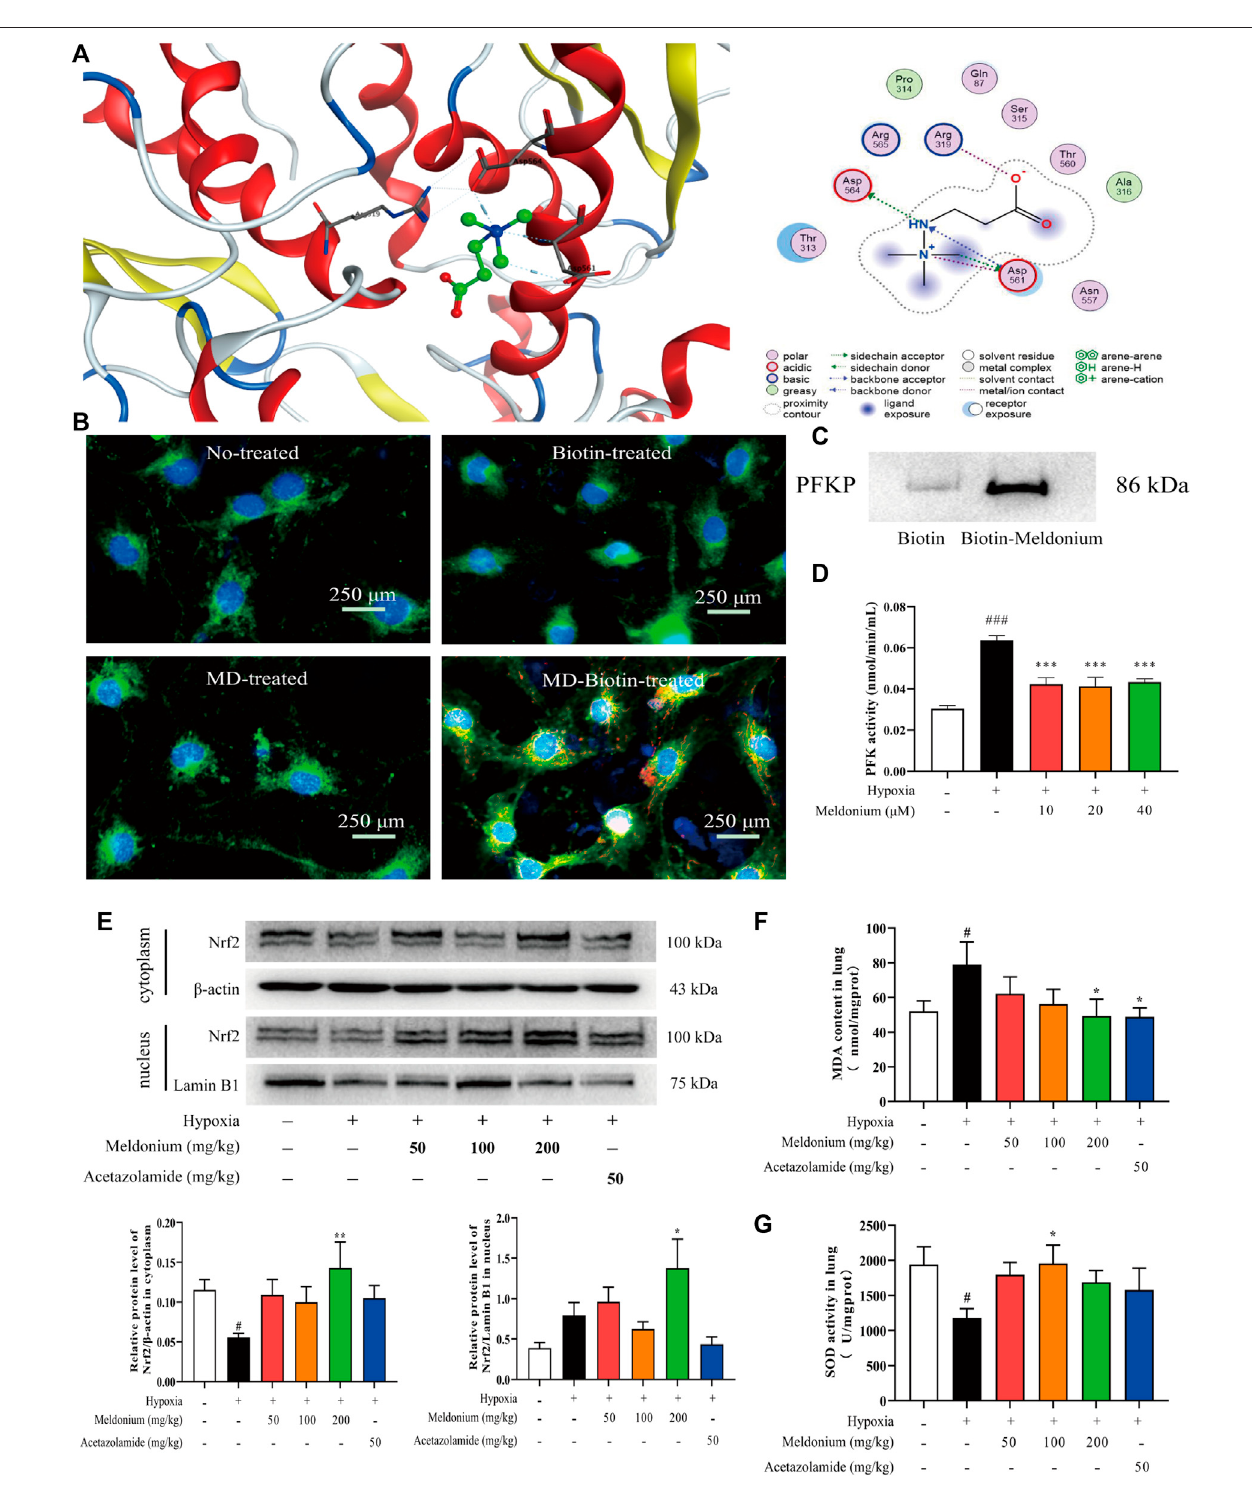
FIGURE4| PFKPisthepotentialtargetproteinofmeldoniumandmeldoniumtreatmentattenuatedoxidativestressinducedbyhypoxia. (A) Positionofmeldonium binding to PFKP and 2D structure diagram of meldonium interacting with PFKP. (B) Co-localisation of meldonium with PFKP in vitro . PFKP is shown in green, biotin- meldonium is shown in red, and co-localisation is shown in yellow orange. MD: meldonium. (C) Pull-down assay of meldonium-PFKP interaction in vitro was con fi rmed via western blot. (D) Effect of meldonium on PFK activity under hypoxia condition in vitro ( n = 3). (E) Protein expression of Nrf2 in the cytoplasm and nucleus after hypoxiafor24 h invivo ( n =6). (F) Malondialdehydecontentafterhypoxiafor24 h invivo ( n =6). (G) Superoxide dismutaseactivity afterhypoxia for24 h invivo ( n =6 – 7).